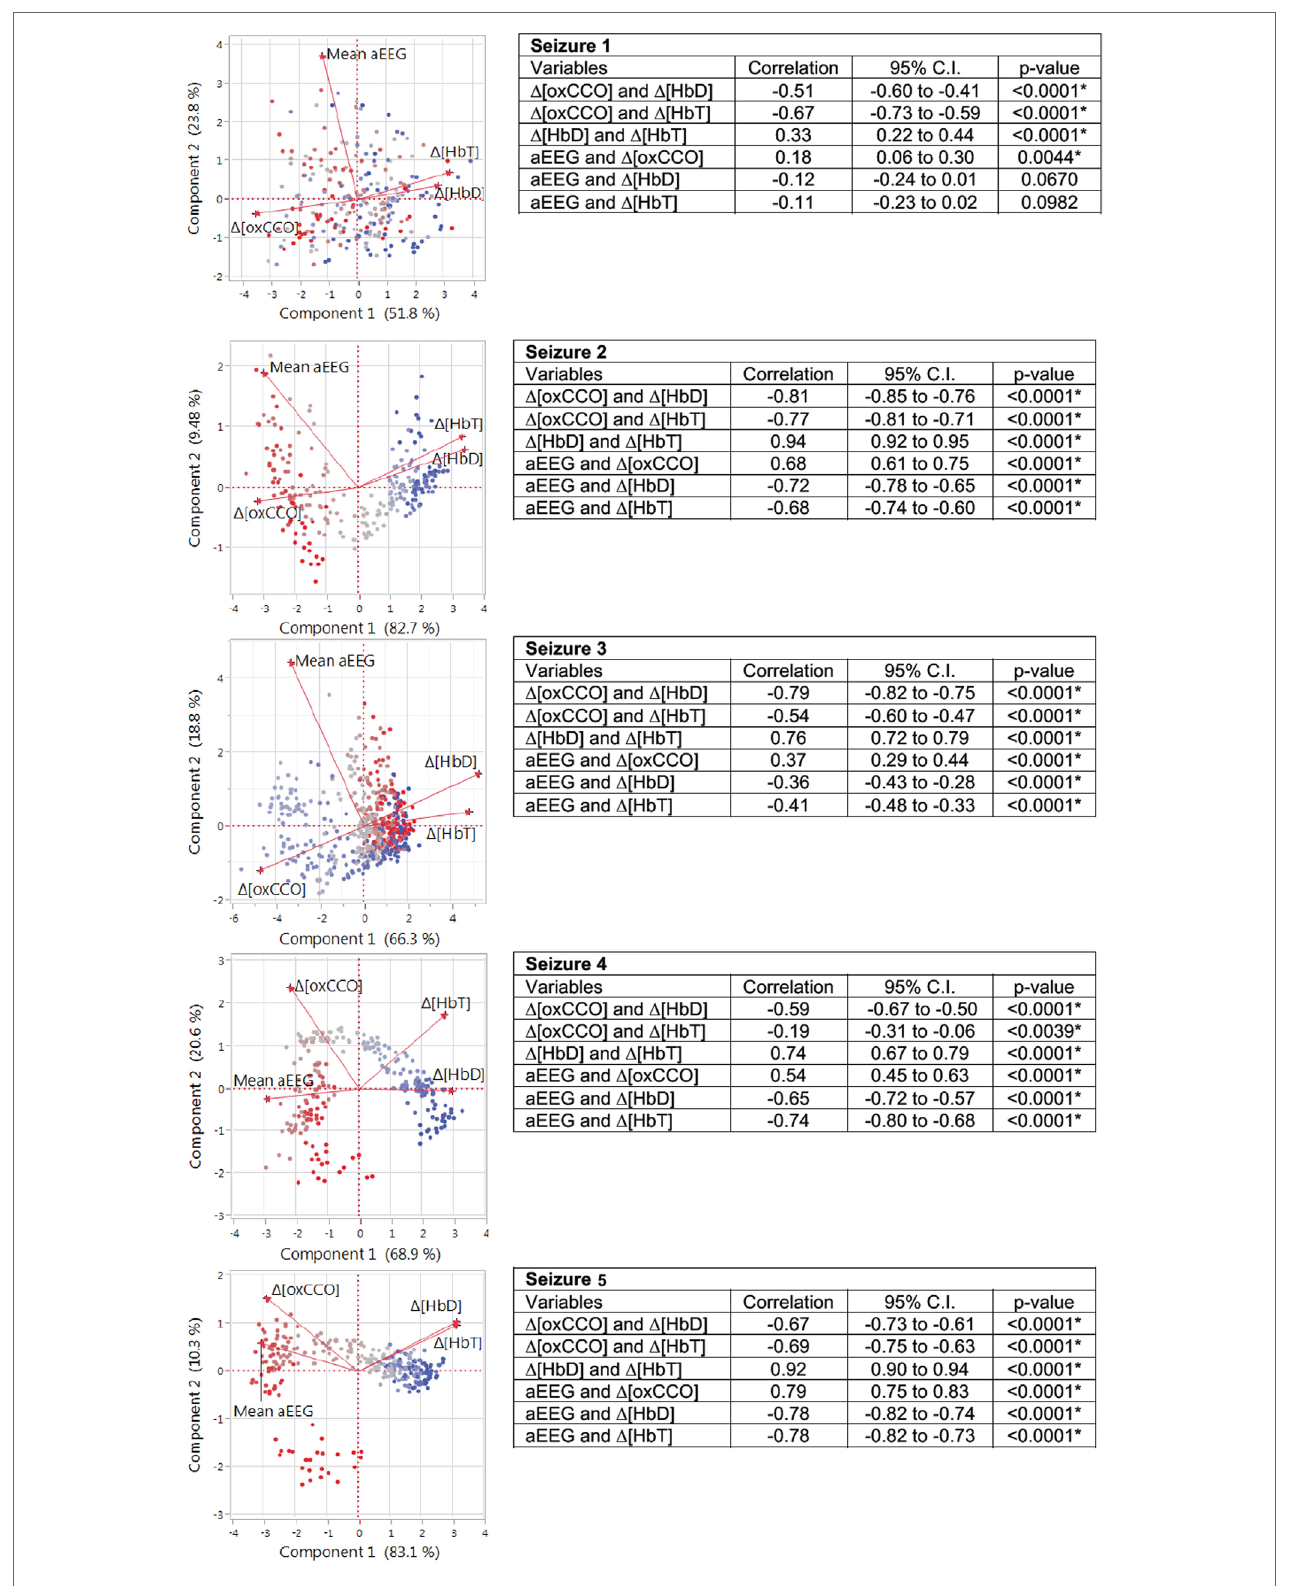
FIGURe 5 | Matrix of correlation coefficients and corresponding data table for each seizure were analyzed with principal component analysis